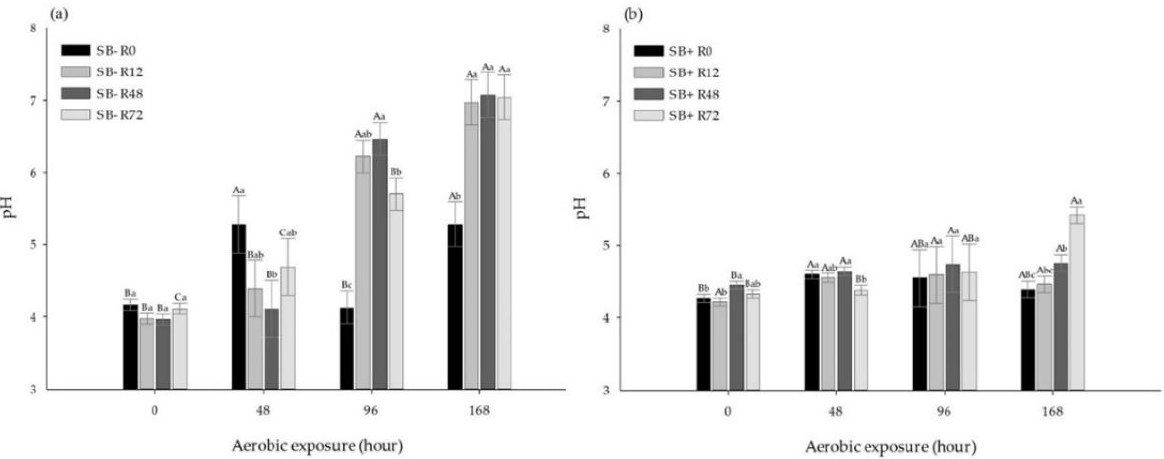
Figure 3. ( a ) The effects of the additive application (SB) × relocation time × aerobic exposure